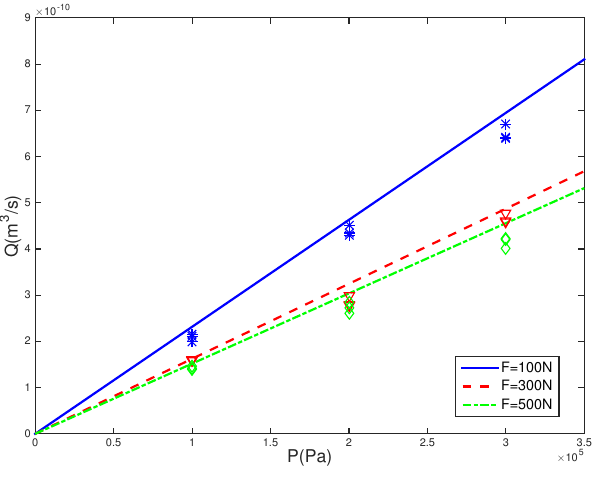
Figure 8. The leak rate versus the fluid pressure through the contact load for three